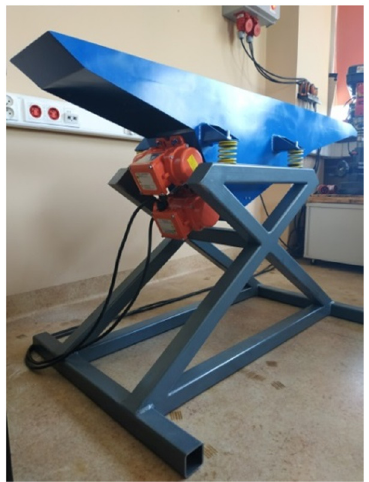
Figure 9: Device view from the side of the drive system.